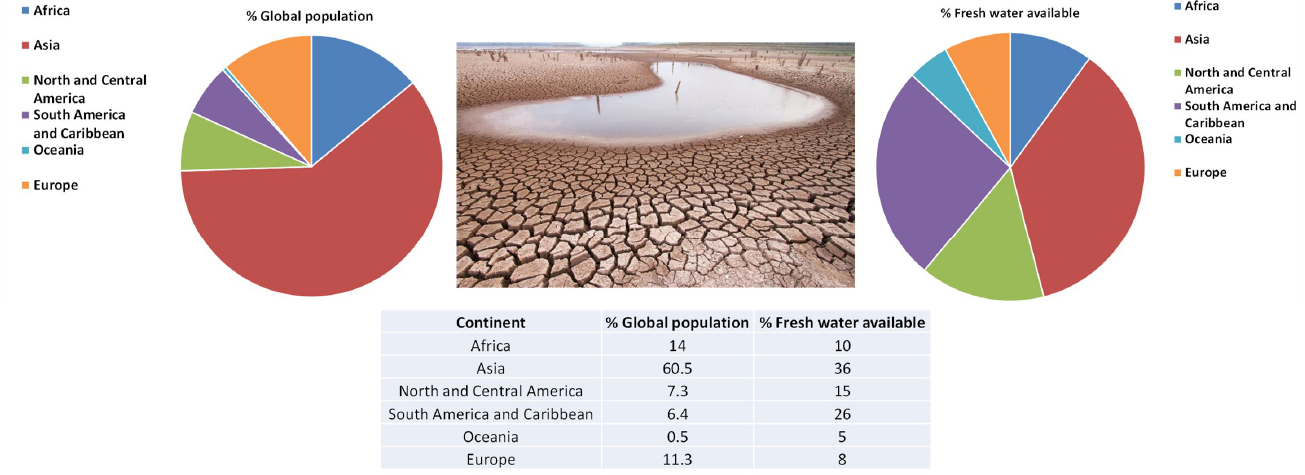
Figure 1. A brief description of population distribution and water availability around the world [1,3,8,12,13].